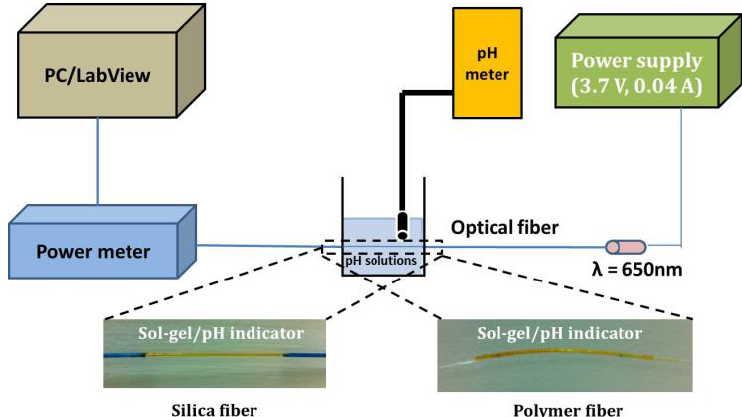
Figure 6. Schematic of the experimental set up with indicative photos from both silica and polymer optical fiber sensing heads after the deposition of the sol-gel derived pH sensitive overlayer.